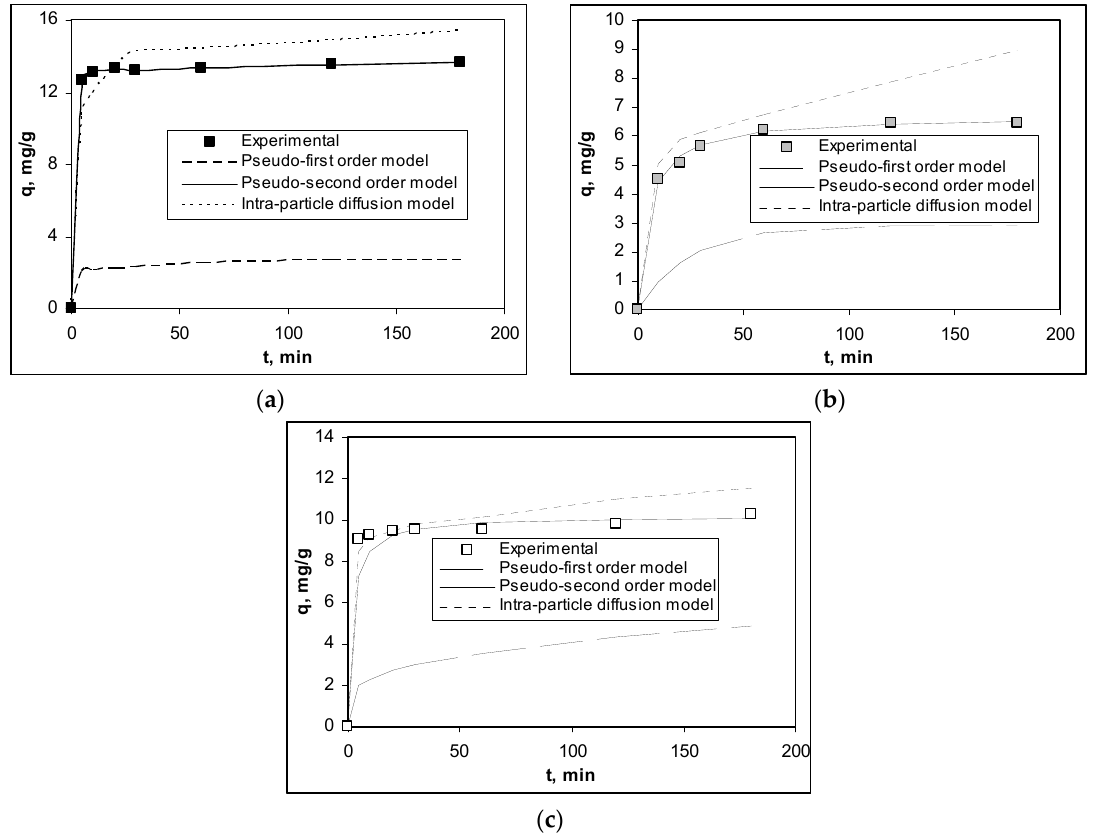
Figure 3. Experimental and theoretical kinetic curves obtained for the biosorption of ( a ) Cu(II) ions, ( b ) Co(II) ions and ( c ) Zn(II) ions on alginate. (Experimental conditions: pH = 4.4; biosorbent dosage = 2.0 g / L; c 0 = 25.41 mg Cu(II) / L, 23.57 mg Co(II) / L, 27.10 mg Zn(II) / L; temperature = 22 °C).